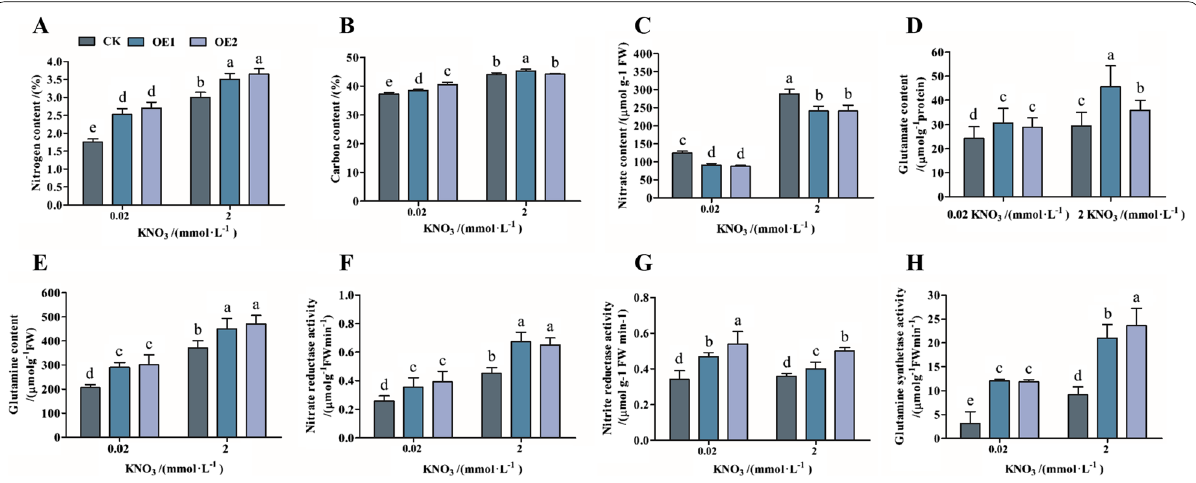
Fig. 5 AtNLP7 improved N assimilation in cotton. A and B Content of nitrogen ( A ) and carbon ( B ). Results are average values Letters denote significant differences ( P < 0.05) from Duncan’s multiple range tests. C – E Content of nitrate ( C ), glutamate ( D ), and glutamine ( E ). Results are average values SD (n 3 replicates). Letters denote significant differences ( P < 0.05) from Duncan’s multiple range tests. F – H Enzyme ± = activity of nitrate reductase ( F ), nitrite reductase ( G ), and glutamate synthase ( H ), in transgenic cotton compared with CK. Results are average values SD (n 3 replicates). Letters denote significant differences ( P < 0.05) from Duncan’s multiple range tests ± =